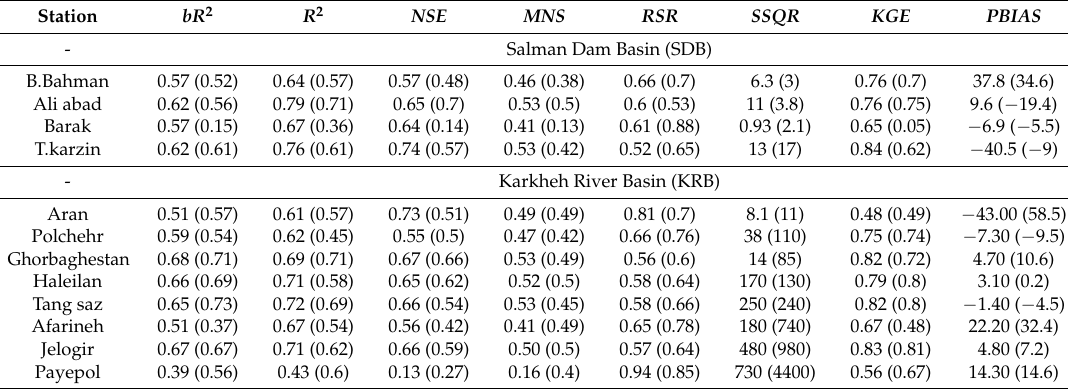
Table 5. Calibration and validation (in parentheses) results by eight different objective functions using the SUFI-2 optimization